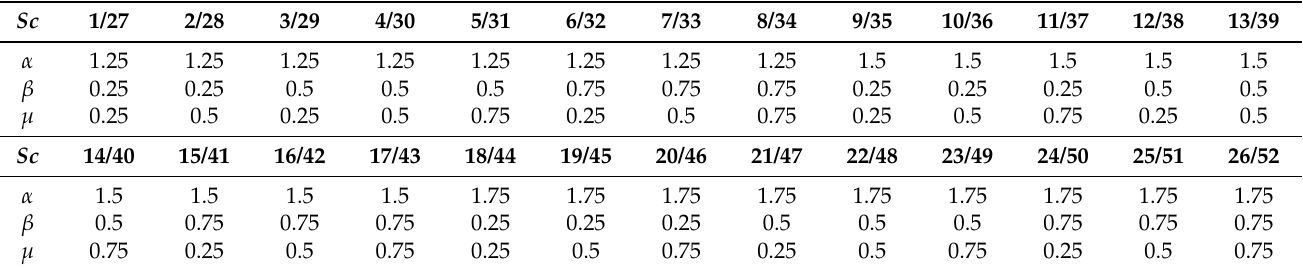
Table 3. Parameters in each scenario for the sensitivity